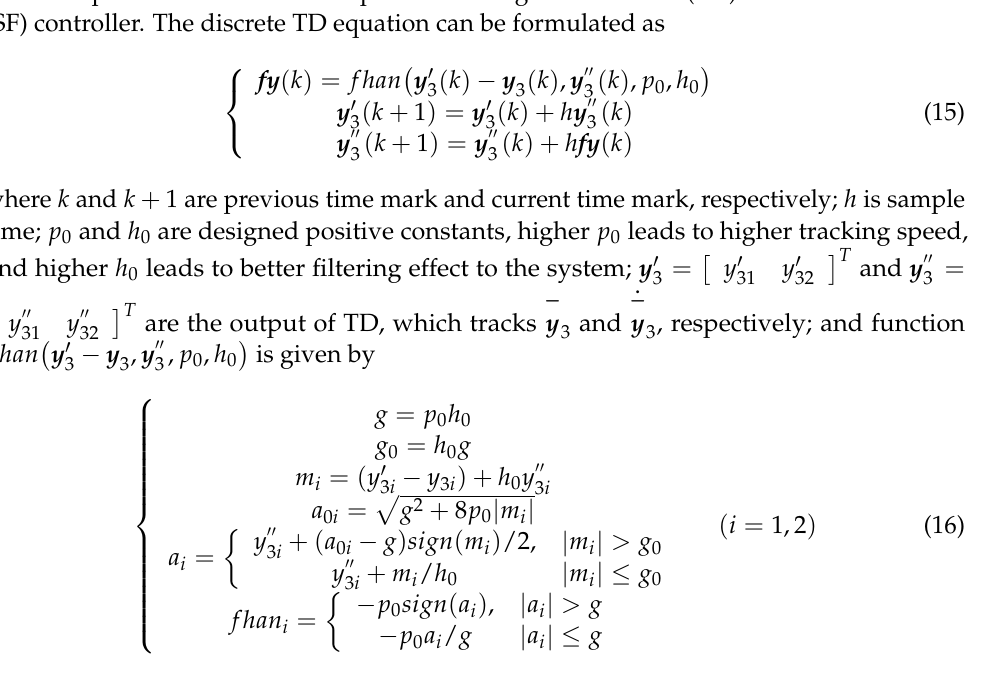
Figure 3. The ADRC compensation structure for seeker. This part is formed from an optimal tracking differentiator (TD) and a state